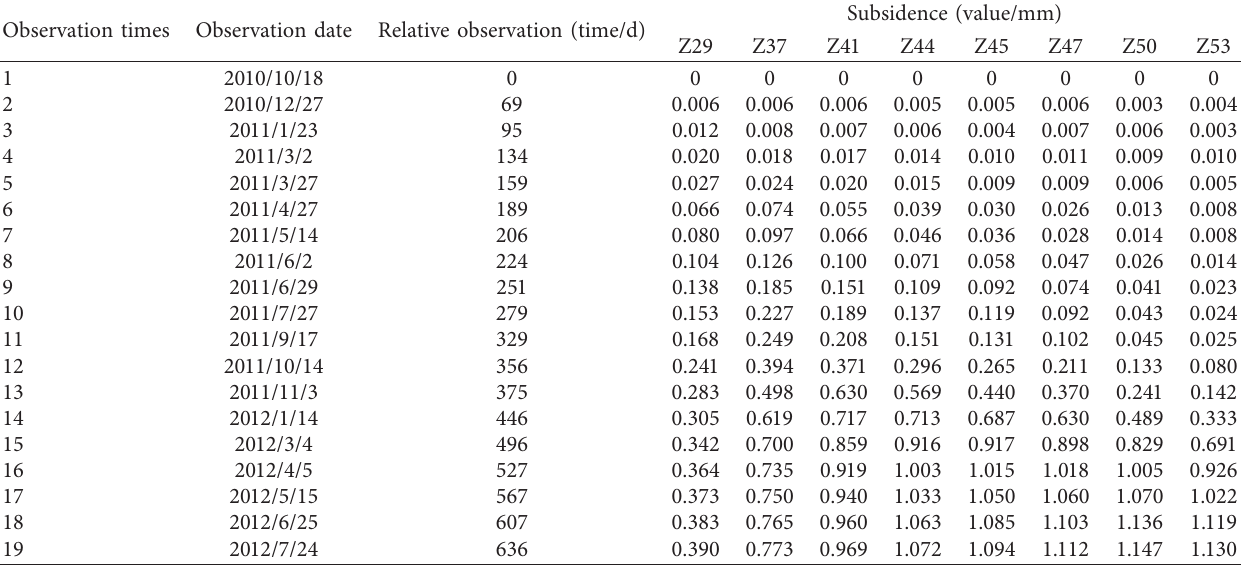
Table 1: Surface subsidence monitored data from Z29, Z3, Z41, Z44, Z45, Z47, Z50, and